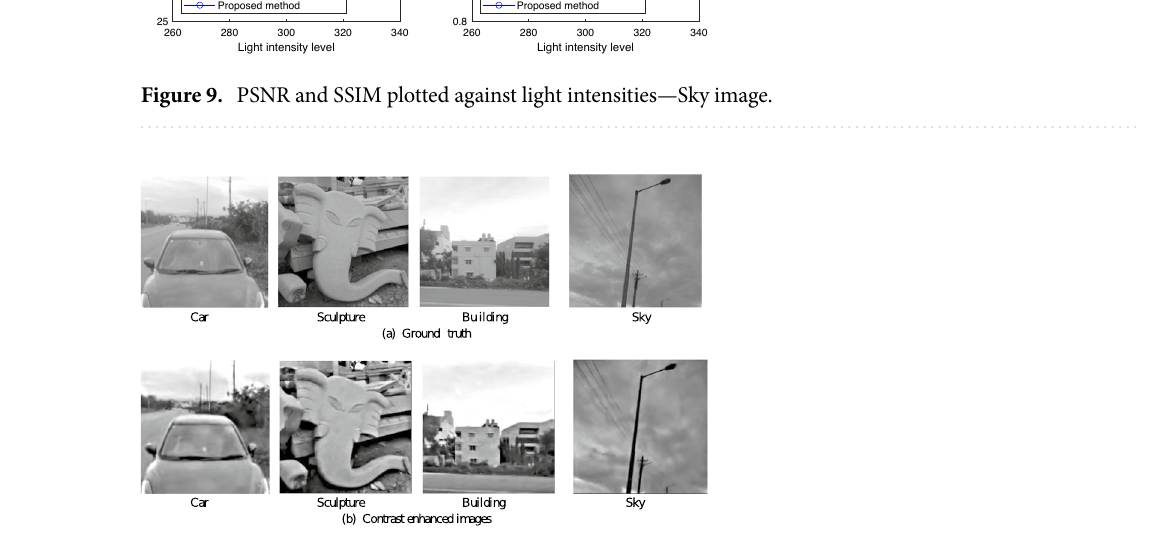
Figure 10. Result of contrast enhancement on low light